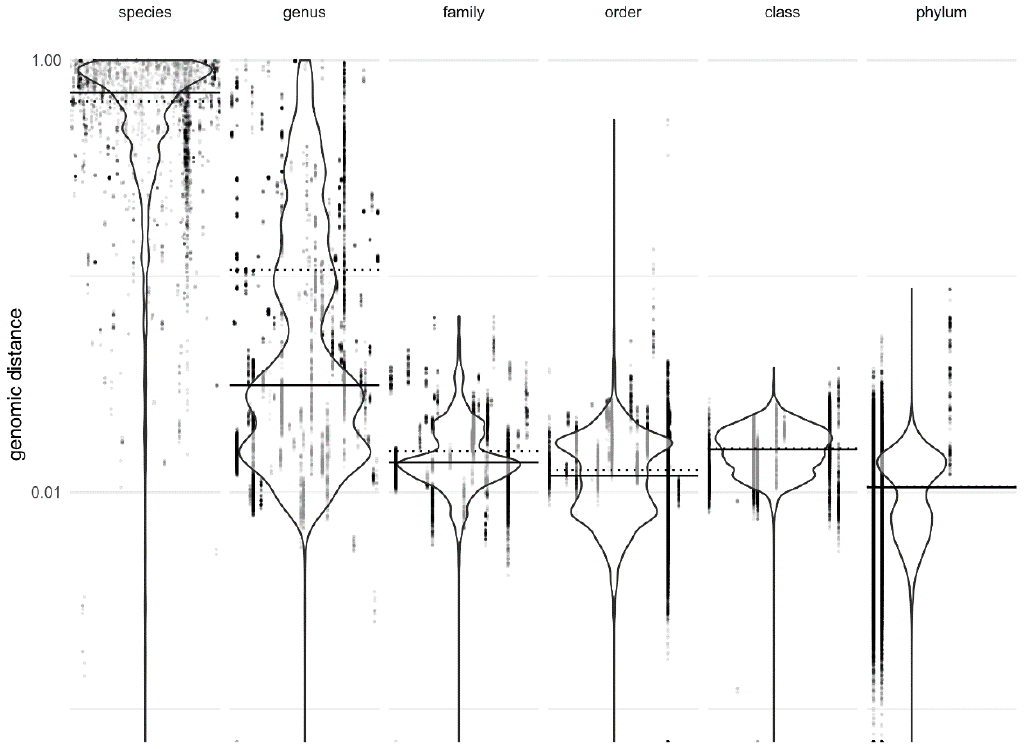
Figure 1. Genomic distances between pairs of fungal genomes at various taxonomic ranks, calculated by Dashing with k-mer size 16. The distances on the species level are between genomes in the same species, the distances on the genus level are distances between genomes of different species belonging to the same genus and so on. Density (violin) plots are plotted on top of points showing intergenomic distances (one point per genome pair). Points representing the same taxon (e.g., distances within the same species on the species level) are arranged in columns. Solid horizontal lines mark the median genomic distances, dashed horizontal lines mark the average genomic distances per taxonomic rank. The y -axis is logarithmic.